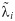
Eigenmode decomposition of input and output.Left: The baseline component of the input perturbation ΔβB is decomposed into the eight input modes ξiΨi. Center: By the network action, each mode is amplified or attenuated by its individual gain factor λ˜i. Right: The sum of all scaled output modes λ˜iξiΨi results in the baseline component of the output perturbation ΔνB.